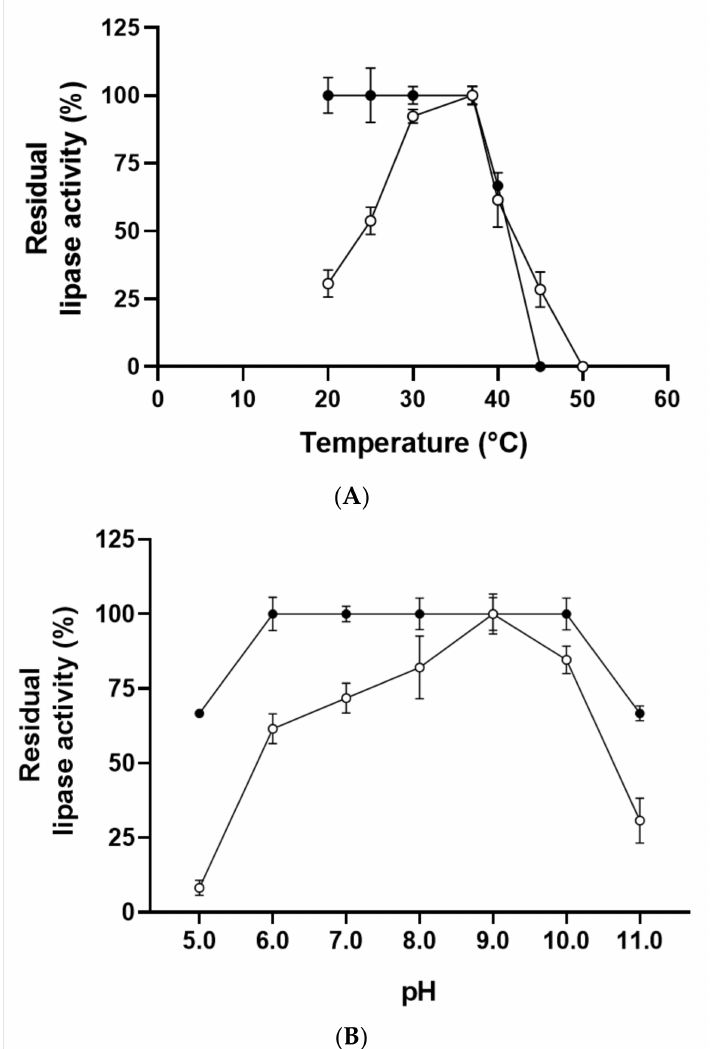
Figure 4. Effects of temperature and pH on the activity and stability of the purified PCrL. ( A ) The temperature profile (filled circle) was determined by assaying enzyme activity at various temperatures and pH 9. The activity of the enzyme at 37 ◦ C was taken as 100%. The temperature stability (empty circle) was determined by incubating the PCrL at different temperatures. The residual enzyme activity was measured at 37 ◦ C and pH 9 using TC8 as the substrate. Each point represents the mean of three independent experiments. ( B ) The pH profile (filled circle) was determined in different buffers by varying the pH values from 5 to 11. The maximum activity obtained at pH 9 was considered as 100%. The pH stability (empty circle) of the PCrL was determined by incubating the enzyme at different pH values, ranging from 5 to 11, for 1 h at 4 ◦ C, and the residual activity was measured at pH 9 and 37 ◦ C using TC8 as the substrate. Each point represents the mean of three independent